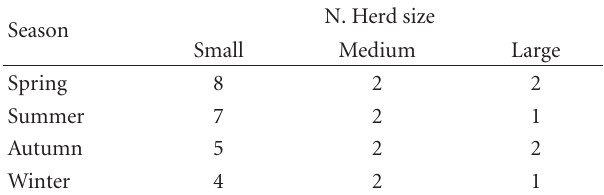
Table 5: Herd size seasonal